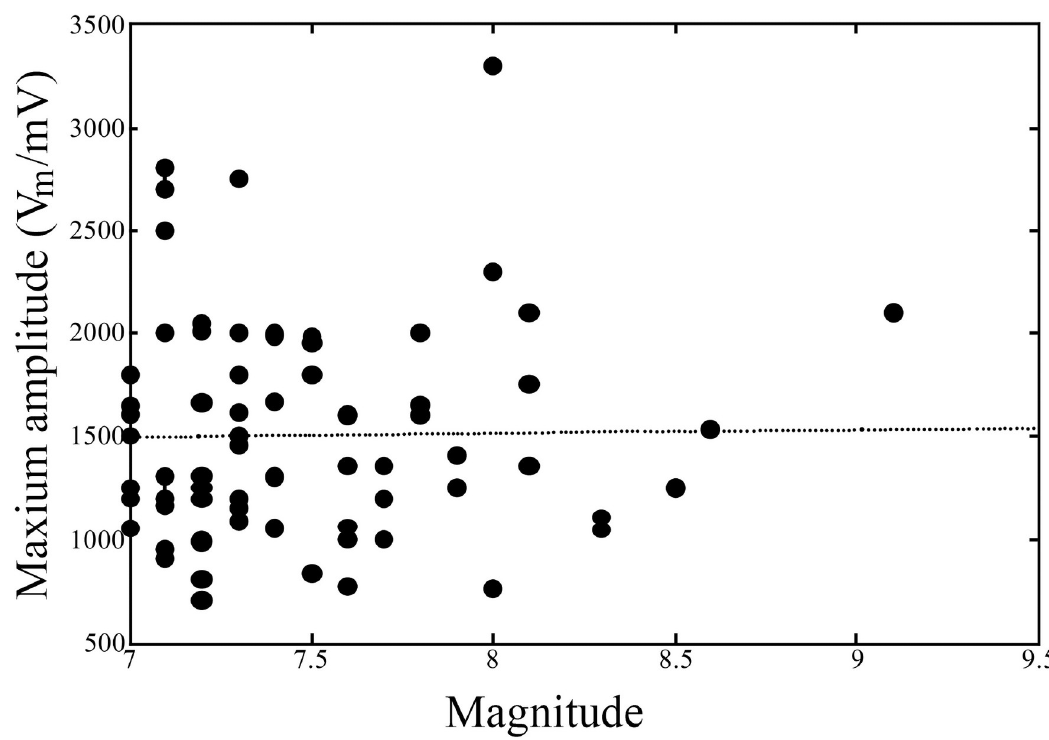
Fig 2. The maximum amplitude of the anomalous infrasound signal vs. the associated earthquake magnitude during 2002– 2008.